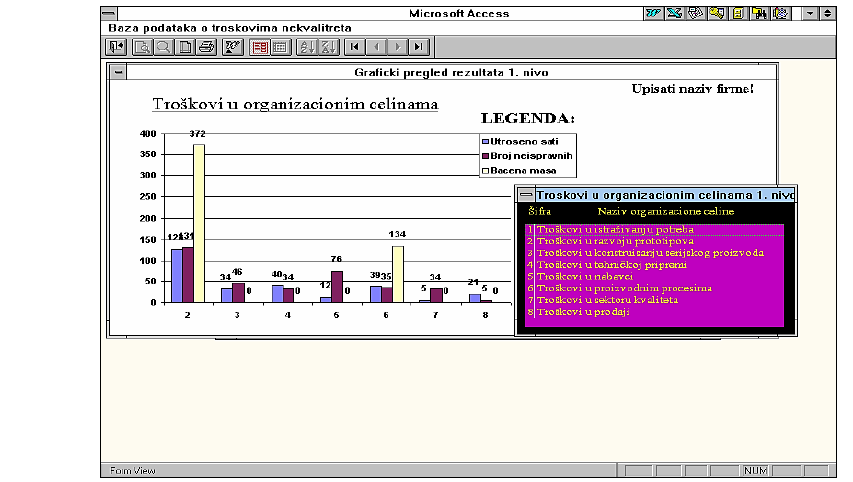
Figure 13 – Example of the window for search of the nonconformities costs at level